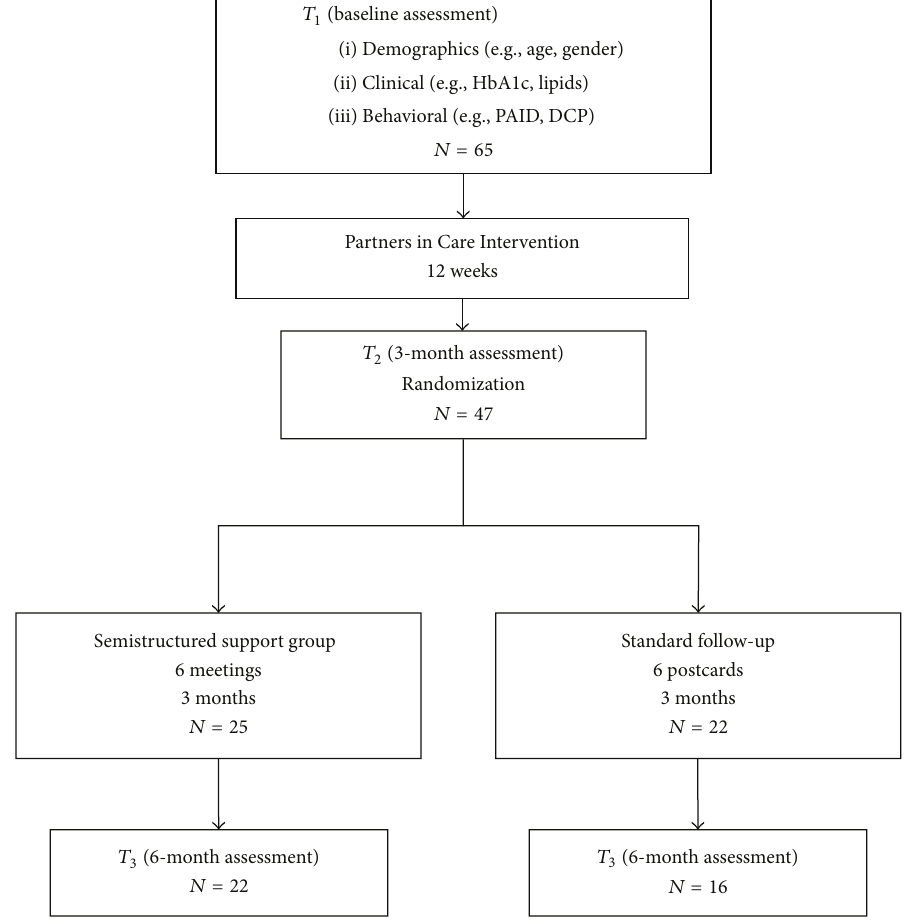
Figure 1: CONSORT diagram of PIC social support group study